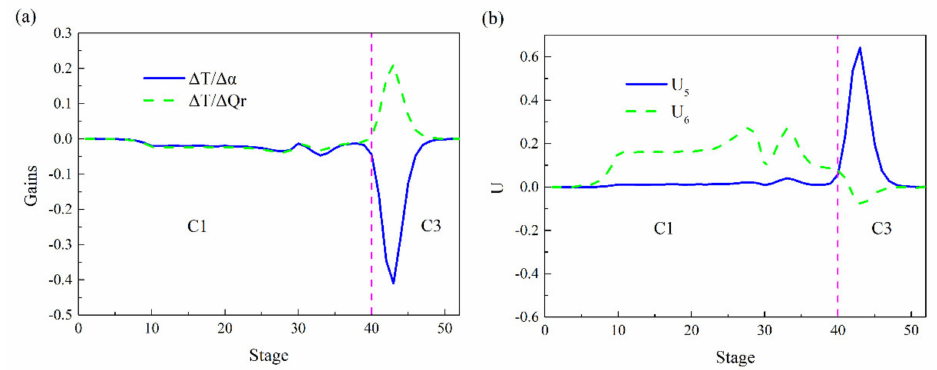
Figure 12. ( a ) Steady-state gains ( b ) SVD analysis for CS2.